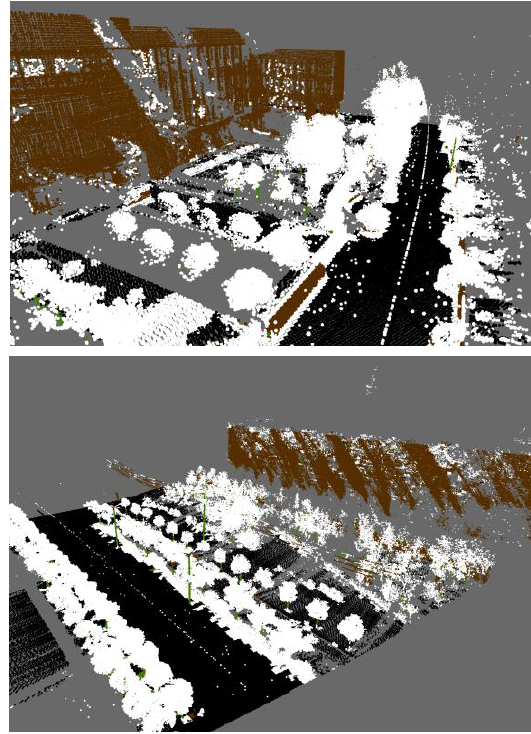
Figure 7. The classification result. The black is ground, white are trees, green are poles, and brown is